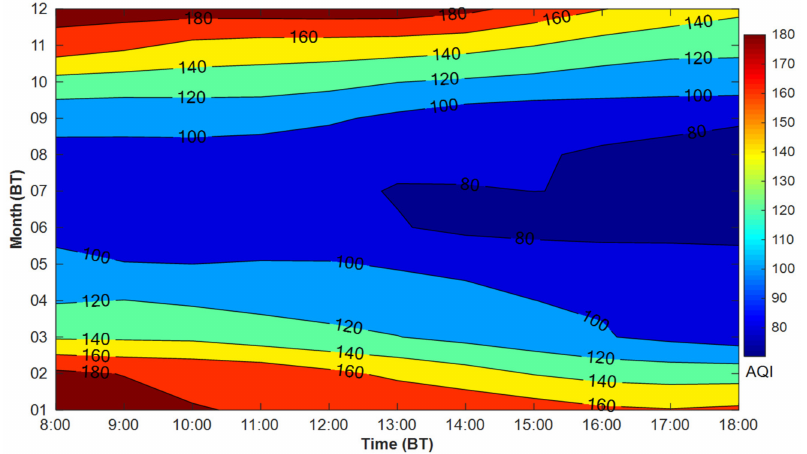
Figure 9. The temporal distribution of the average AQI during haze events in different